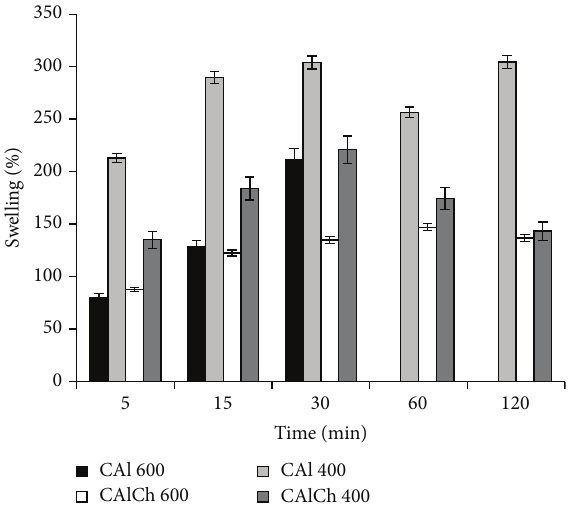
Figure 5: Swelling degree in phosphate buffer at pH